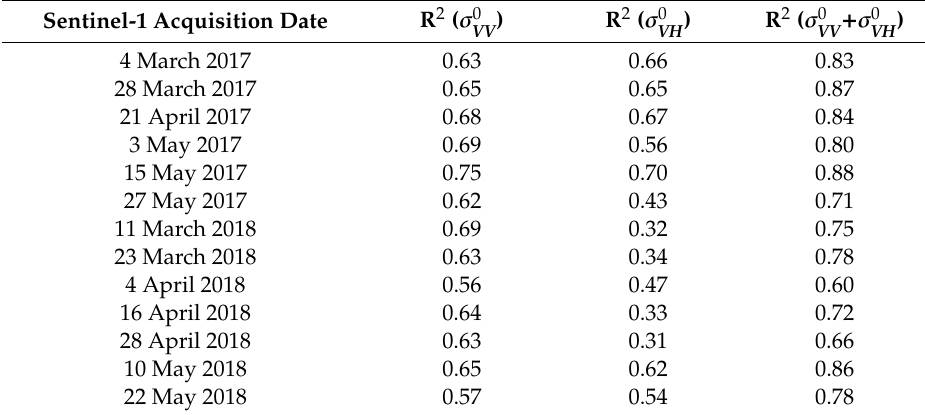
Table 3. Localized relationship between soil moisture and backscatter.